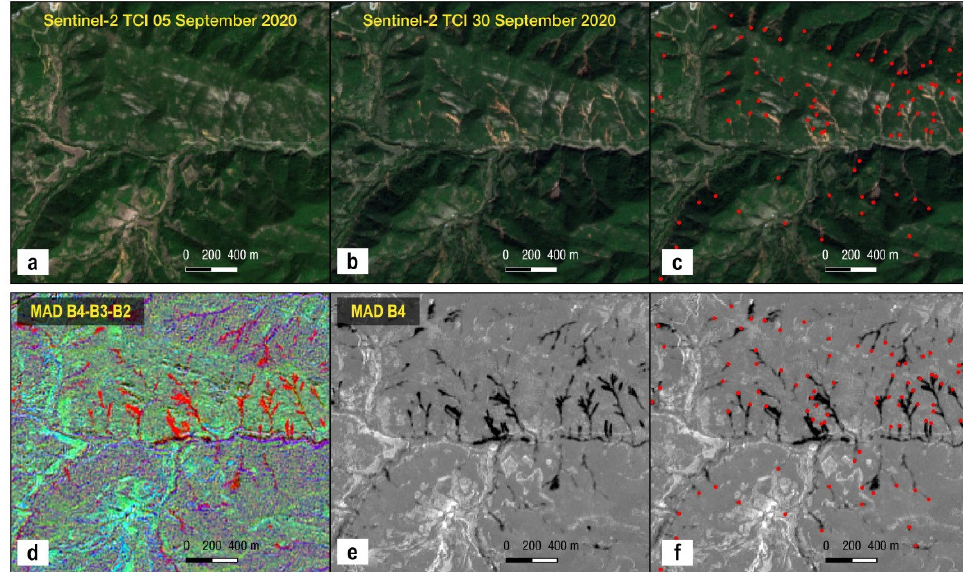
Figure 2. Example of manually mapping landslides within the study area using Sentinel-2 imagery. Pre- and post-event true color Sentinel-2 images ( a , b ) and an overlay ( c ) of mapped landslide points with red color (mostly headscarp points). Change detection MAD processing ( d , e ) assisted visual picking of headscarp points ( f ).